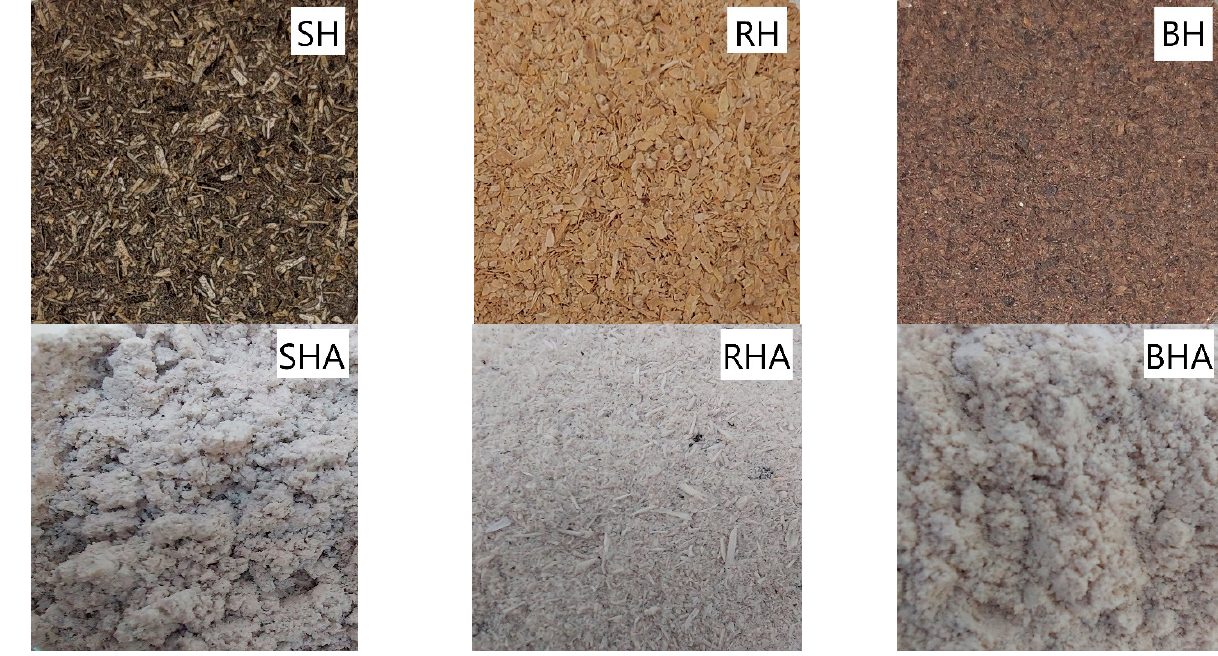
Figure 1. Macroscopic images of the biomass fillers (SH, RH, and BH) and biomass ash fillers (SHA, RHA and BHA).